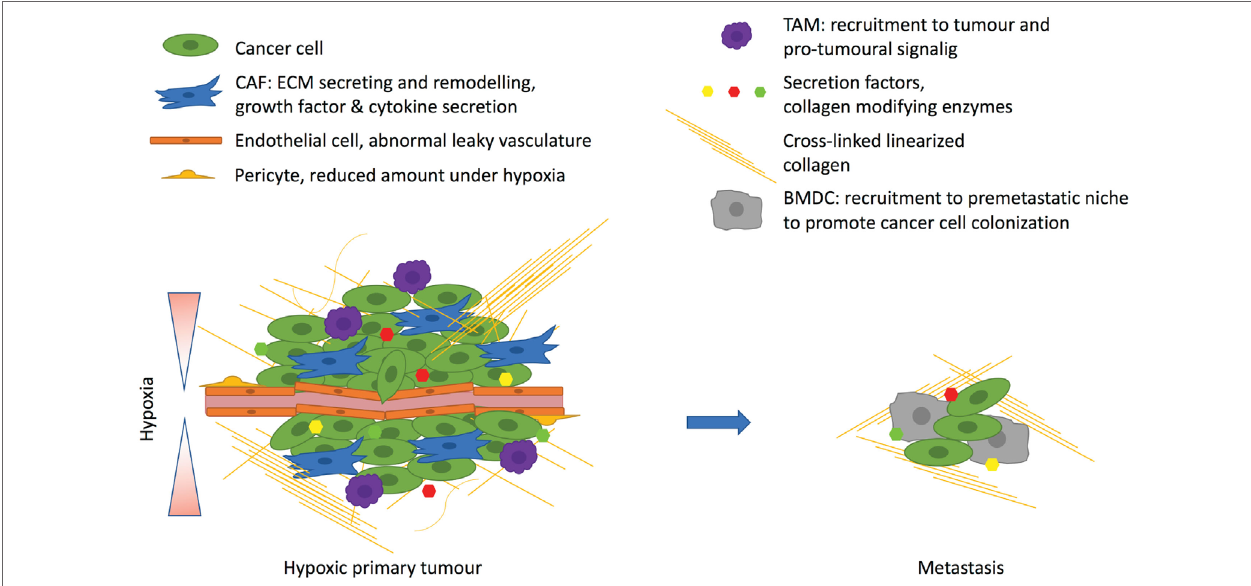
FiGURe 2 | Hypoxia affects the tumor microenvironment. Hypoxia arises due to rapidly proliferating cancer cells with inadequate vasculature. The excessive angiogenic signaling promotes formation of abnormal leaky vasculature with a decreased amount of pericytes. Hypoxia promotes tumor-associated macrophage (TAM) infiltration, which support tumor growth. Hypoxic cancer cells corrupt fibroblasts by secreting, for example, transforming growth factor β , which turns fibroblast into cancer-associated fibroblasts (CAFs) to drive the cancer progression. CAFs promote desomplasia and together with cancer cells they secrete extracellular matrix (ECM) components such as collagens. One important secreted factor is the hypoxia-inducible enzyme lysyl oxidase, which cross-links fibrillar collagen at the primary tumor and prepares the premetastatic niche for the recruitment of bone marrow derived cells (BMDCs) that are needed for cancer cell colonization at the metastatic